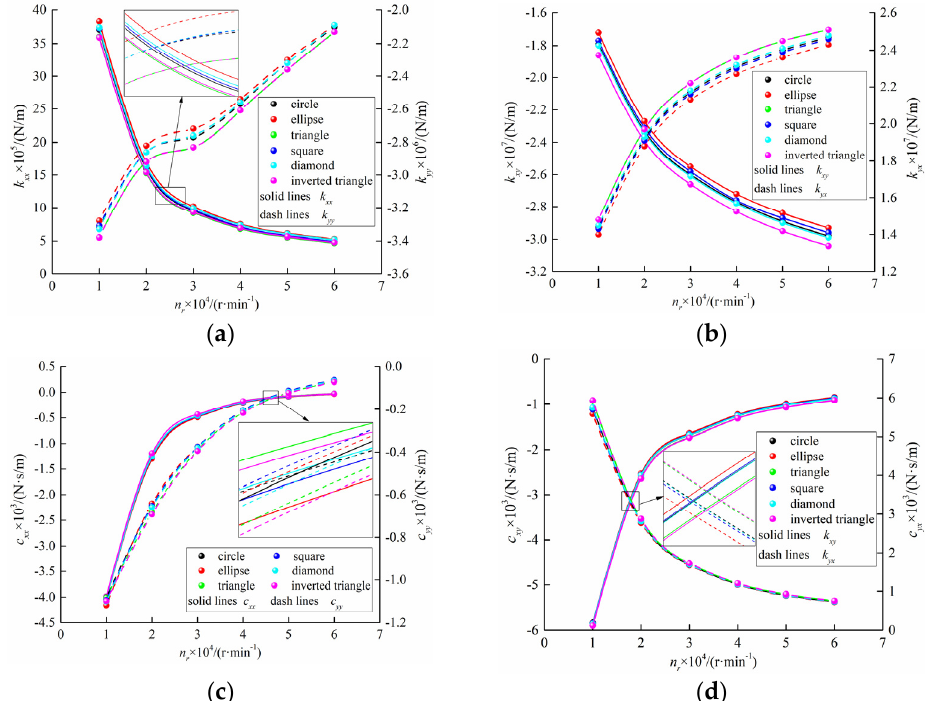
Figure 10. ( a ) Description of k xx and k yy with rotational speed; ( b ) Description of k xy and k yx with rotational speed; ( c ) Description of c xx and c yy with rotational speed; ( d ) Description of c xy and c yx with rotational speed.